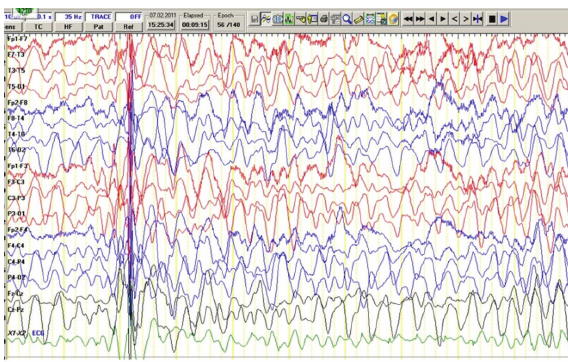
Figure 1: Scalp electroencephalogram showing disorganized slow background with generalized spike-wave